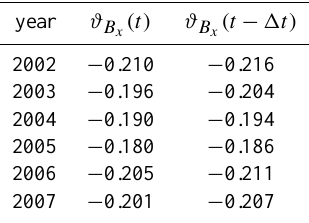
Table 1. Correlation between Pc3 ind and cone angle ( ϑ B ( t − (cid:49)t ) and without ( t ) the propagation time delay, calculated in Sect. 2.2,